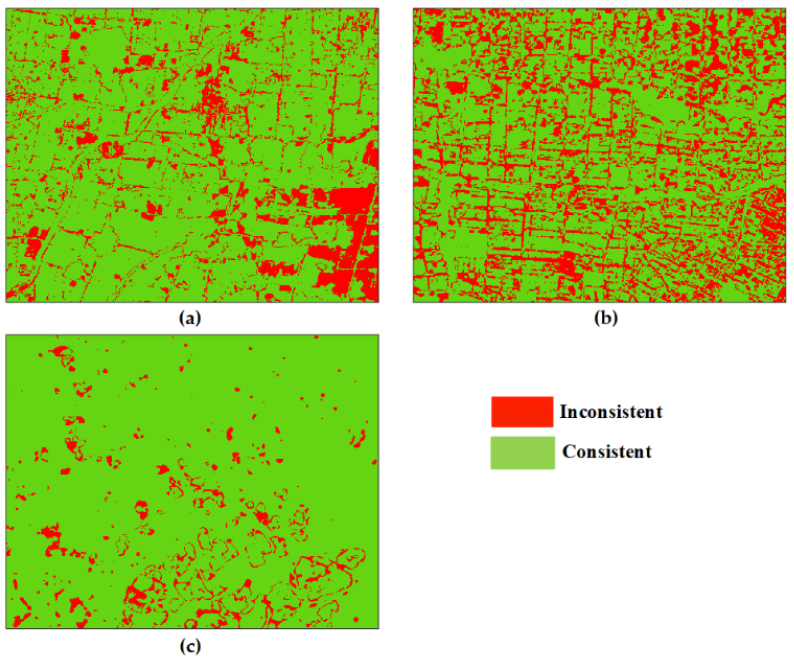
Figure 9. The local differences between the K–RF and optimal TF pseudo-labels, ( a – c ), are differ- ences between the two types of pseudo-labels in the northern, central, and southern parts of the target region.